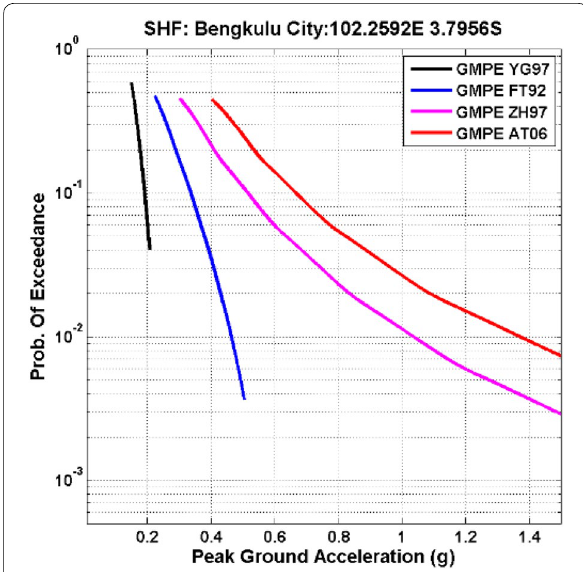
Fig. 3 Evaluation of the Seismic Hazard Function (SHF) based on FT92, YG97, ZH97 and AT06. On the basis of the result, we then used the GMPE of ZH97 and AT06